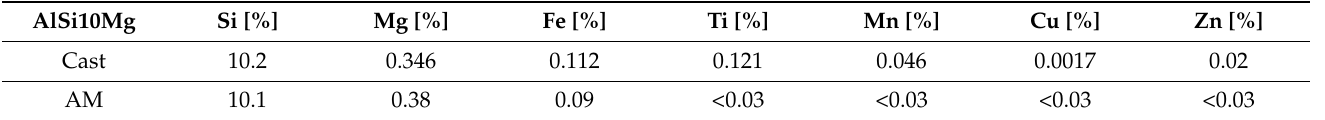
Table 2. Chemical compositions of tested AlSi10Mg specimens.